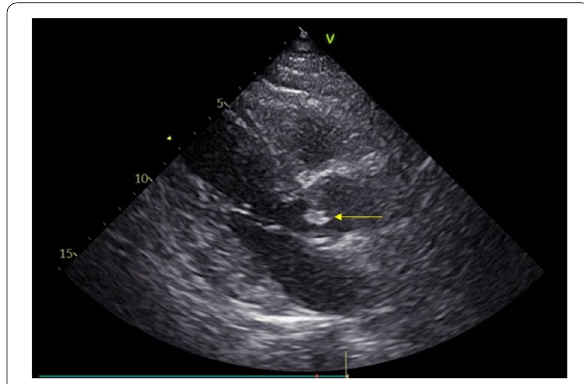
Fig. 3 Transthoracic echocardiogram shows a mobile echodensity on the anterior aortic leaflet measuring 20 x 14 mm consistent with endocarditis (yellow arrow)